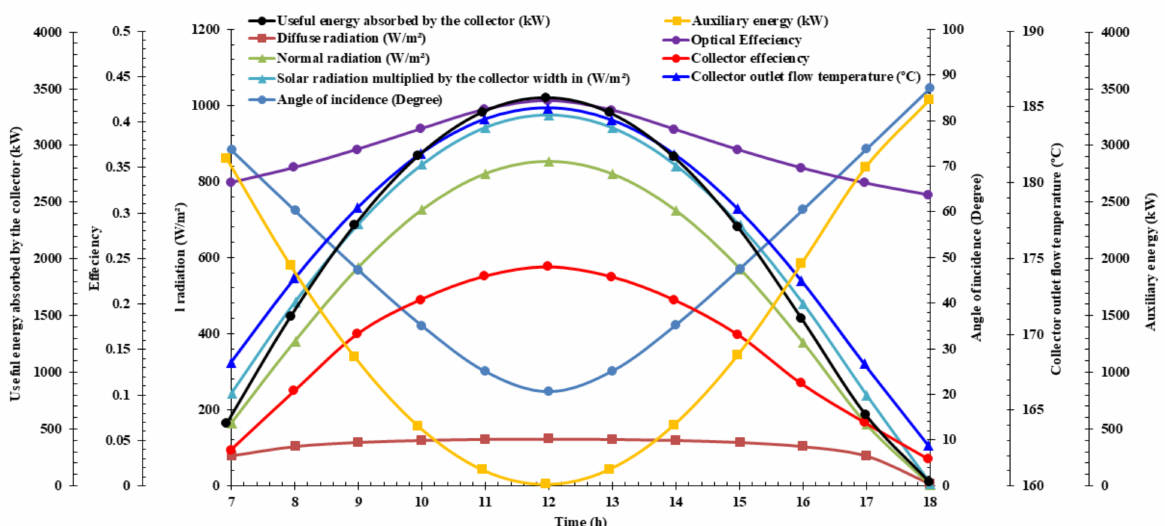
Figure 4. The average hourly changes in important values contribute to the performance of solar thermal